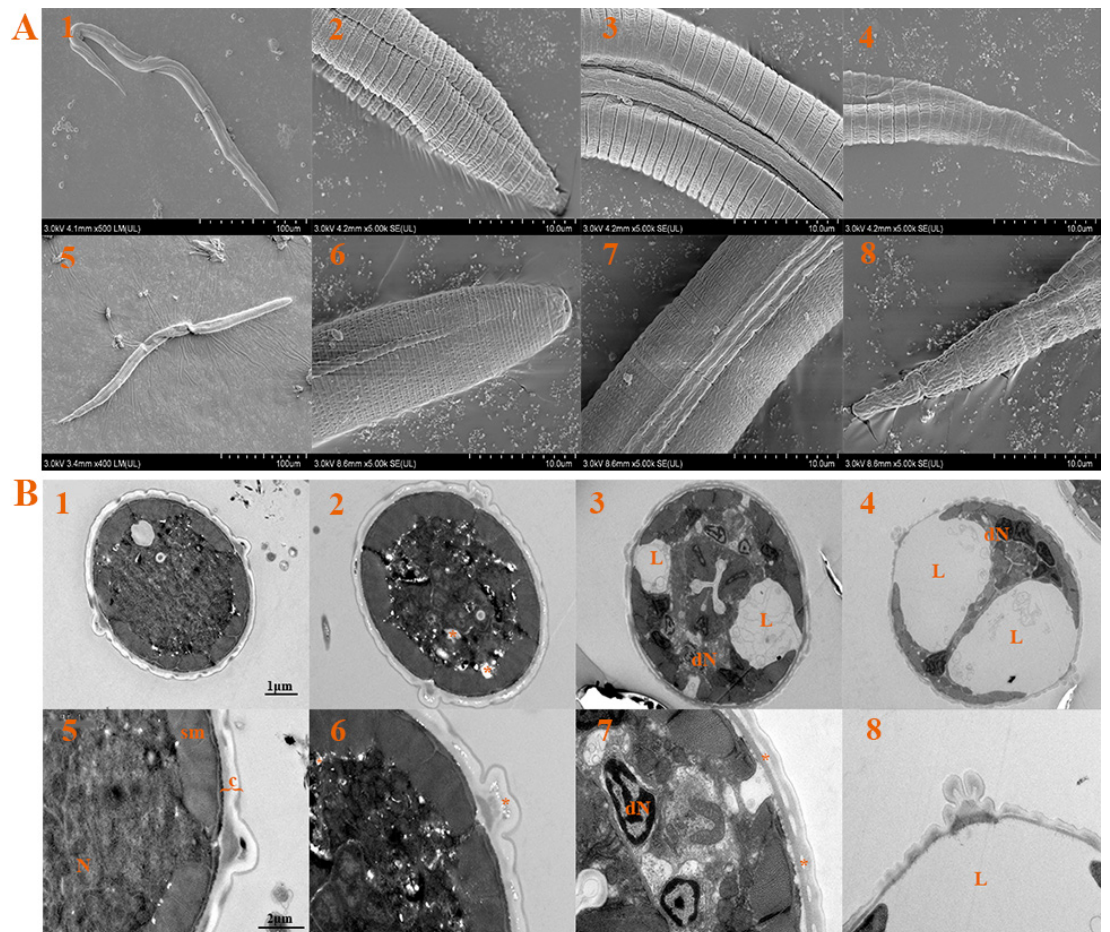
Figure 5. Scanning electron microscopy ( A ) and transmission electron microscopy ( B ) micrographs of the cuticle of Meloidogyne incognita juveniles: A1–A4, B1, and B5 belong to the blank control group; others were treated with derivative 6 . Note: c = cuticle, sm = somatic muscles, N = nucleus, * = electron-lucent cavity, L = lipid granule, dN = nucleus depolymerization.